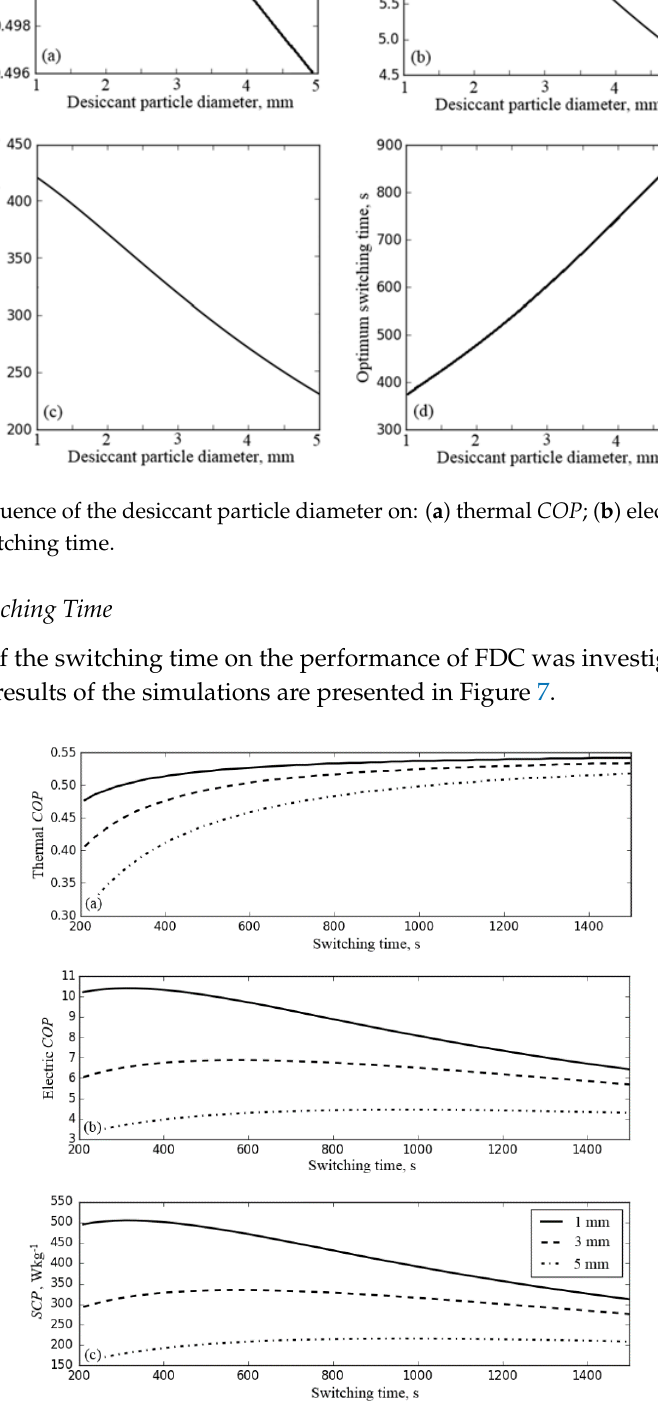
Figure 7. The influence of switching time on: ( a ) thermal COP ; ( b ) electric COP ; ( c ) SCP .